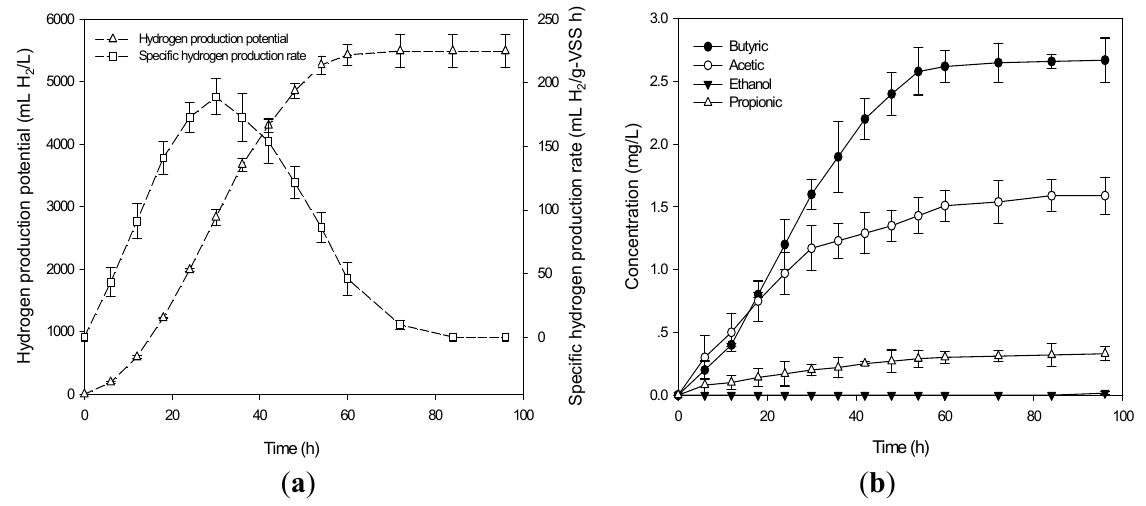
Figure 3. ( a ) P and SHPR in the confirmation experiment at optimum condition; and s ( b ) development of soluble metabolite products at the optimum condition.